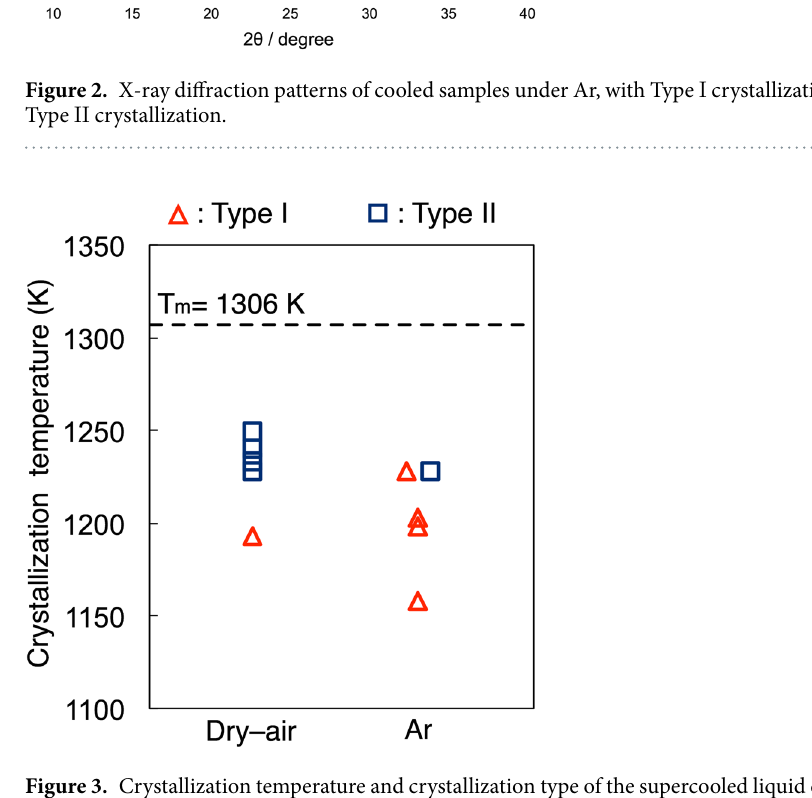
Figure 3. Crystallization temperature and crystallization type of the supercooled liquid composed of lithium disilicate cooled from 1473 K at 20 K/min under Ar ( P O2 ≈ 10 − 5 atm) and dry–air ( P O2 = 0.2 atm) atmospheres. The dashed line represents the melting temperature of the lithium disilicate phase 8